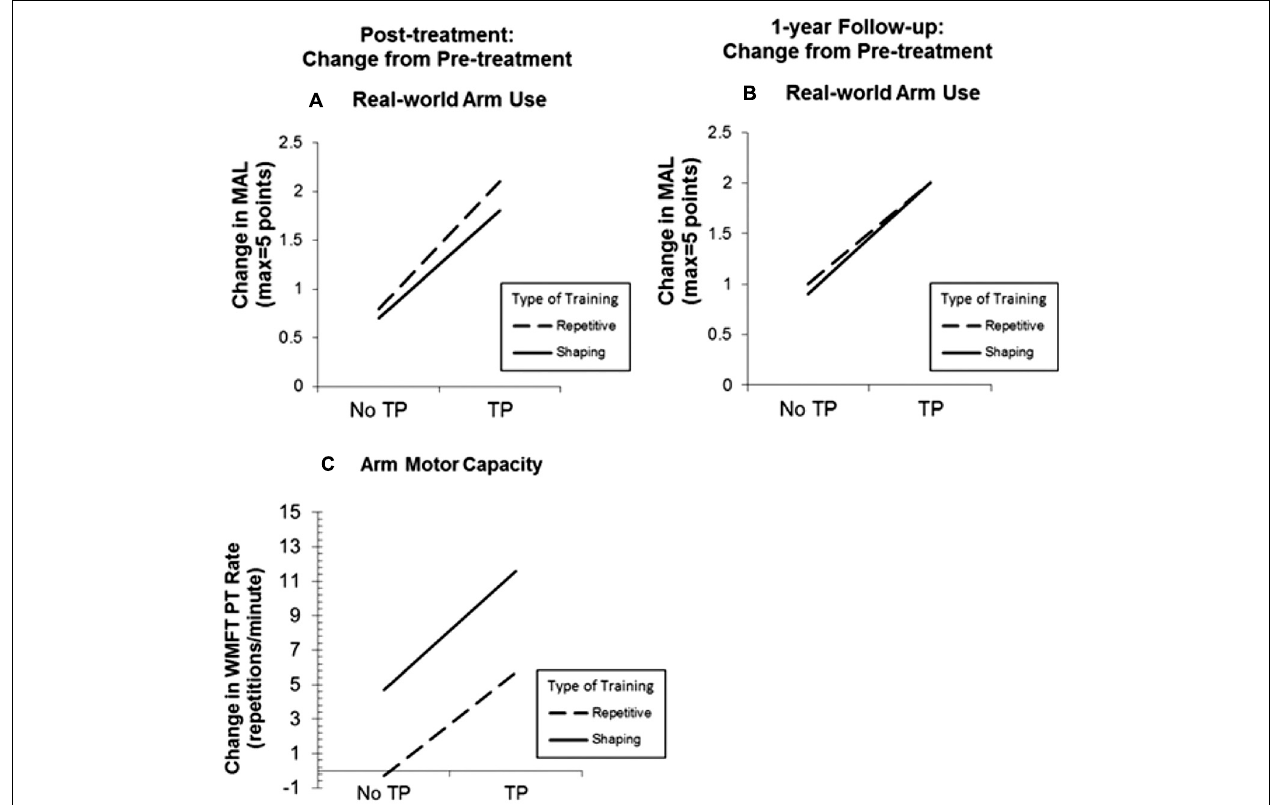
respectively. Note that treatment outcome for spontaneous use of the more affected arm is increased 2.4 times by use of the TP. WMFT post-treatment outcomes are graphed in (C) . Note that shaping greatly increases maximum motor capacity made on request in the laboratory. In all three panels, change from pre-treatment is plotted. Reprinted from Taub etal.